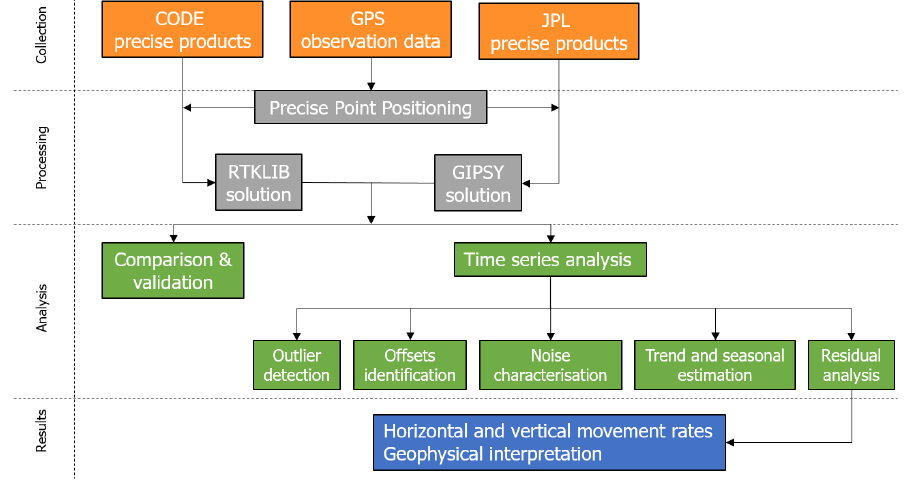
Figure 6. Work flow diagram of the present